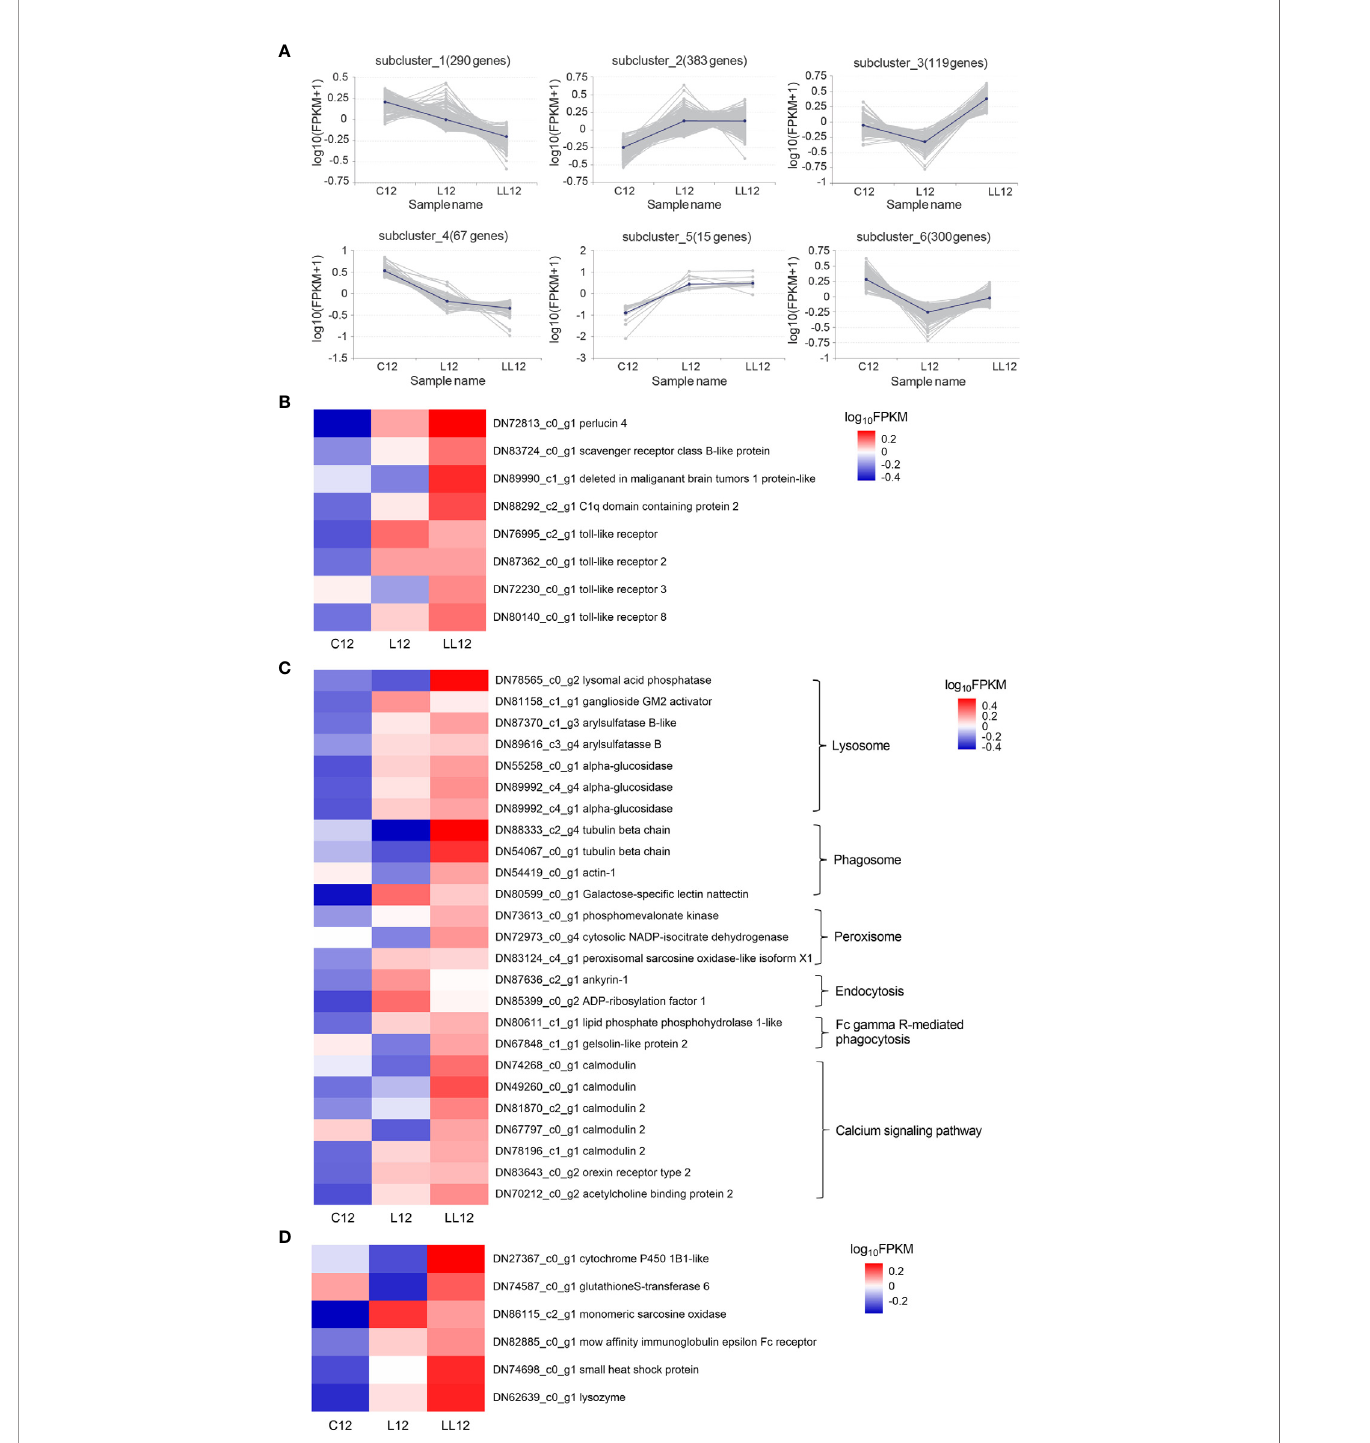
FIGURE 4 | Analysis of differentially expressed genes. (A) Patterns of DEGs in CL1 by K-means clustering analysis. The lines represent the expression tendency of DEGs. The number of genes represented by each pattern is shown above the graphs. (B) The DEGs involved in the PRRs; (C) The DEGs involved in the immune- related KEGG. (D) The DEGs involved in the immune effectors. The heatmap shows log 10 (FPKM) values of DEGs among different